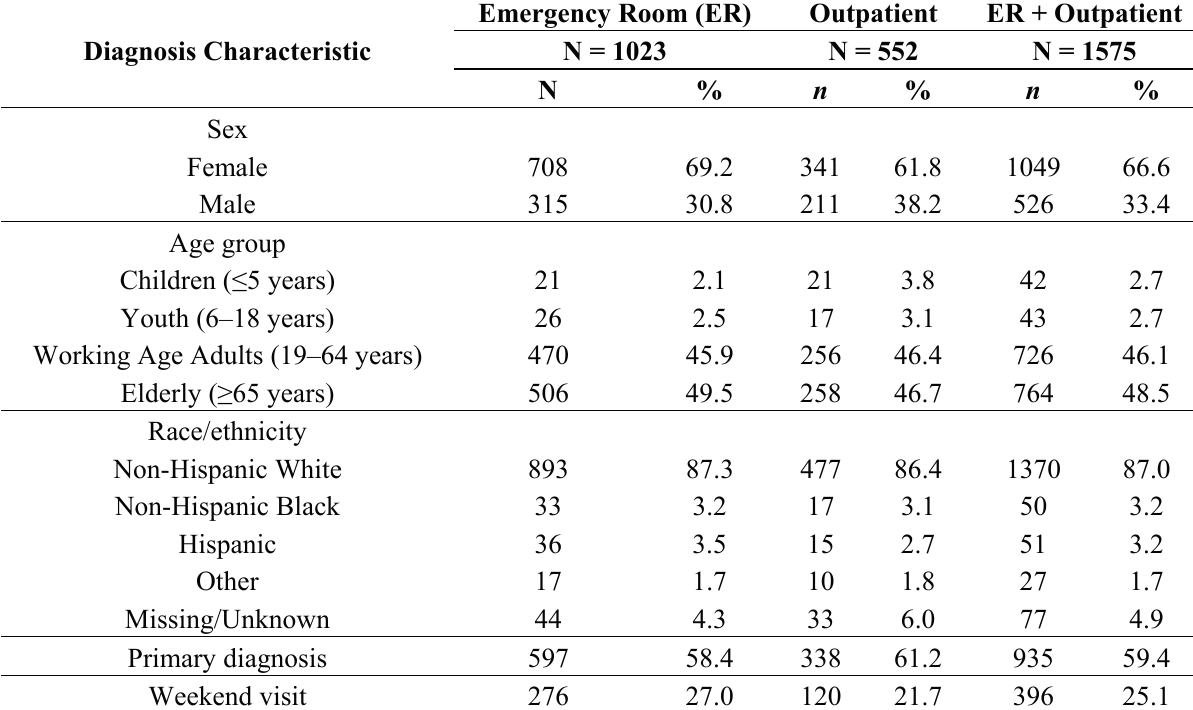
Table 1. Diagnoses for Clostridium difficile at Massachusetts health care facilities during